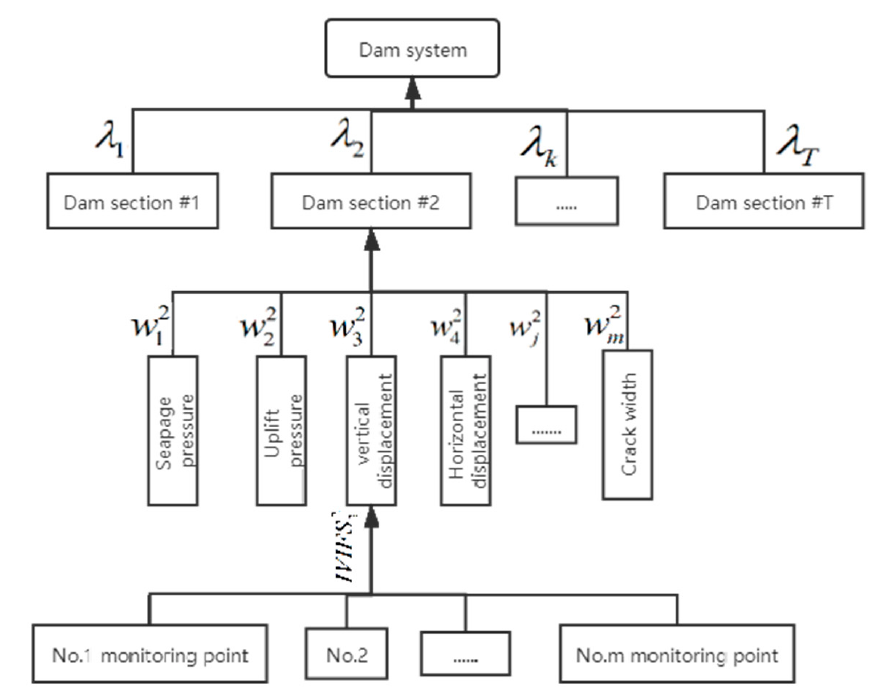
Figure 3. The framework of dam safety assessment after obtaining the weights.